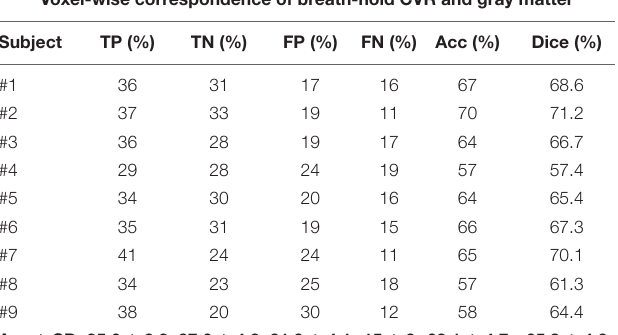
TABLE 3 | Voxel-wise correspondence of breath-hold CVR and gray matter.